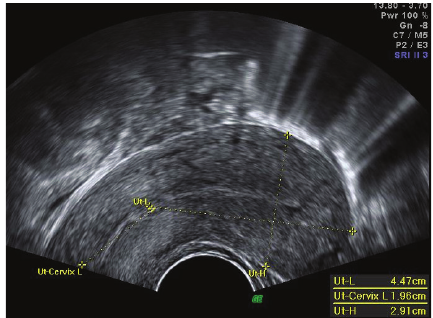
Figure 1: Endovaginal ultrasound: intracervical multicystic mass, with 45 mm in its maximum diameter.